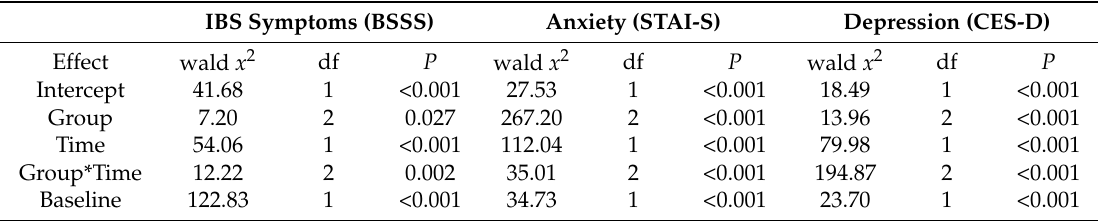
Table 1. GEE model results of IBS symptoms (BSSS), anxiety (STAI-S) and depression (CES-D) by group and time interaction ( N =